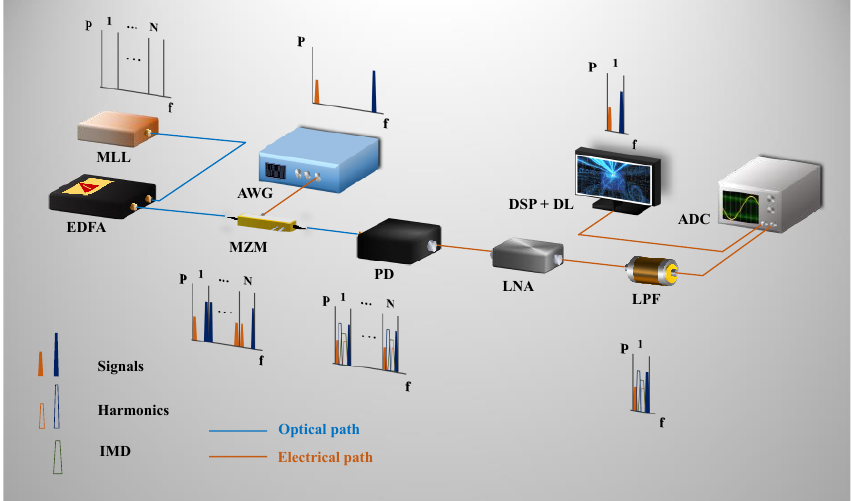
Figure 1. The experimental setup schematic diagram of the deep learning-assisted signal linearization method (MLL: mode-locked laser, EDFA: erbium-doped fiber amplifier, AWG: Arbitrary Waveform Generator, MZM: Mach–Zehnder intensity modulator, PD: photodetector, LNA: low-noise amplifier, LPF: low-pass filter, ADC: analog-to-digital converter, DSP: digital signal processing, DL: deep learning). The down-conversion principle is shown in the spectrum diagrams of small subplots next to the related components. The solid line divides the Nyquist zone (from 1 to N), while two Nyquist zones form an optical frequency comb spacing. The solid blue and orange trapezoids represent the two wideband radio frequency (RF) signals, respectively. The hollow blue and orange trapezoids represent the harmonics of the two RF signals, respectively, and the hollow green trapezoid represents the product of intermodulation and other strays.